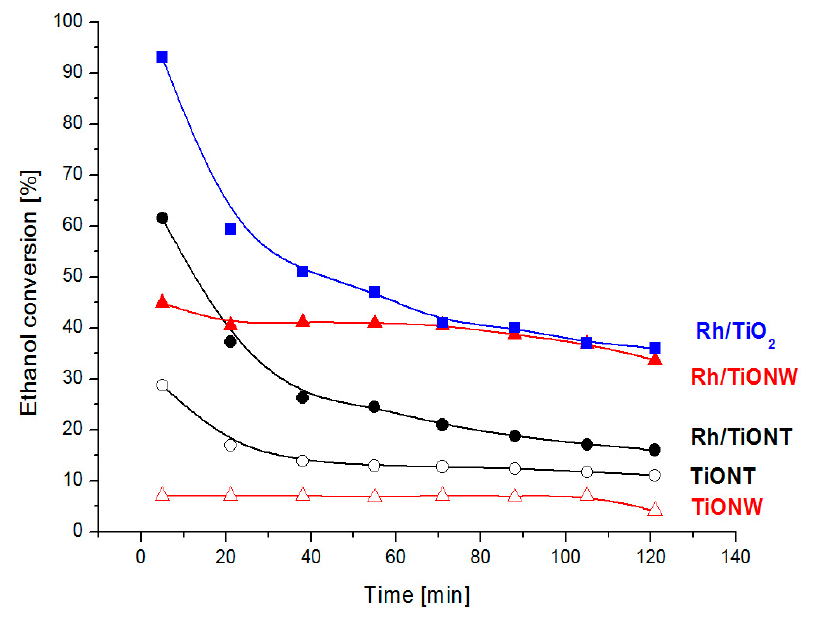
Figure 14. Ethanol conversion over titania and titanate supported Rh catalysts at 603 K.